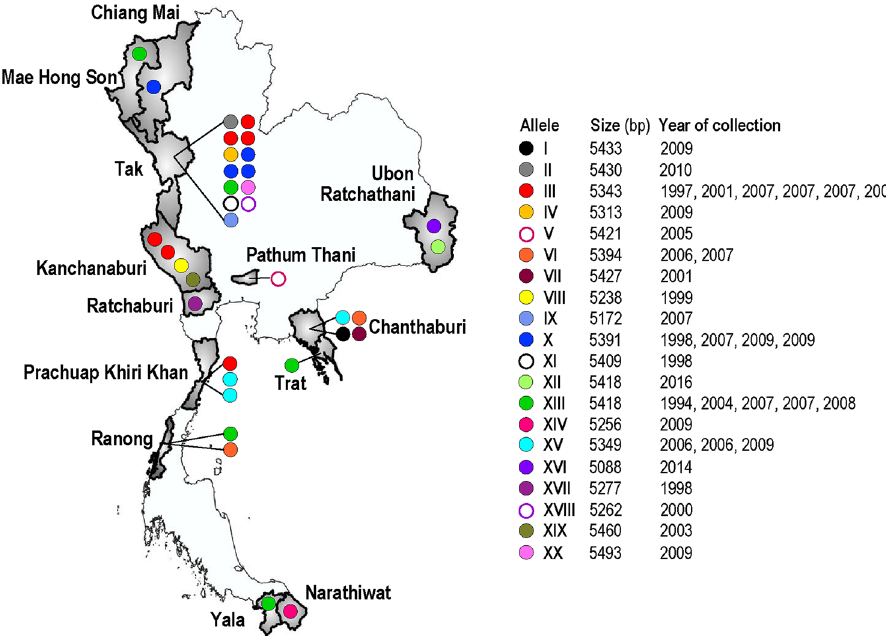
Figure 1. Map of Thailand showing the provinces and period of sample collection. Distribution of the PmMSP1 alleles is shown as corresponding color circles. The map is modified from GADM maps and data (https:// gadm. org/ index. html) under the GADM license version